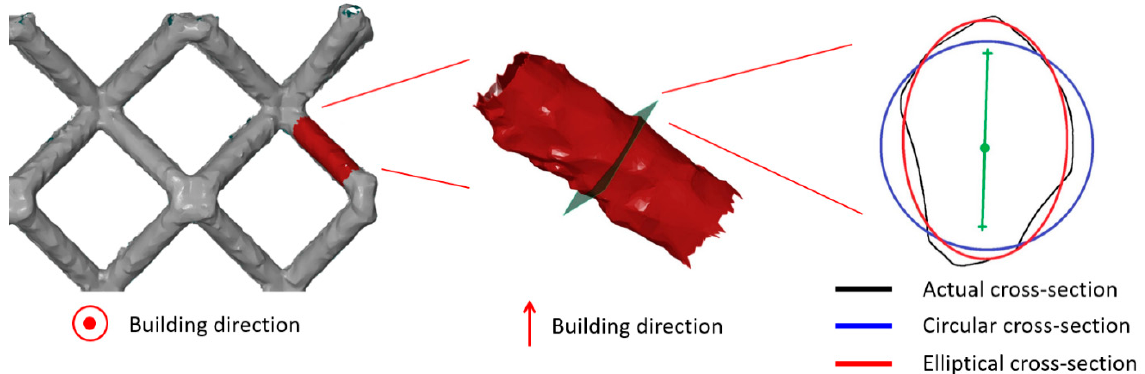
Figure 4. Comparison of different cross-section approximations.